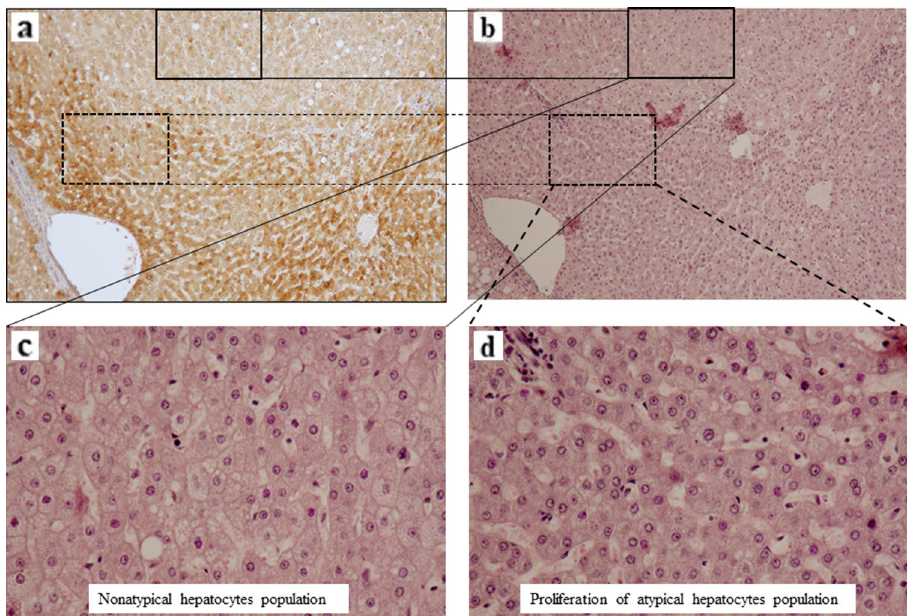
Figure 5. Comparison of CDT1 staining cells and hematoxylin and eosin (HE) staining cells in almost the same area. ( a ) Images showing CDT1 staining (counterstained by hematoxylin, × 100). The square along the line indicates a cell population that is negative or weak for CDT1 staining. ( b ) Image of HE staining shows almost the same area as the CDT1-staining image of (a) (HE, × 100) of continuous sections. The dashed line along the line on the HE staining image indicates a positive cell population for CDT1 staining. ( c ) A higher magnification image of the square of ( a ) and ( b ) is presented (HE, × 400). Nonatypical hepatocytes population were observed. ( d ) CDT1 staining was consistently found in cells morphologically considered atypical hepatocytes (HE, ×